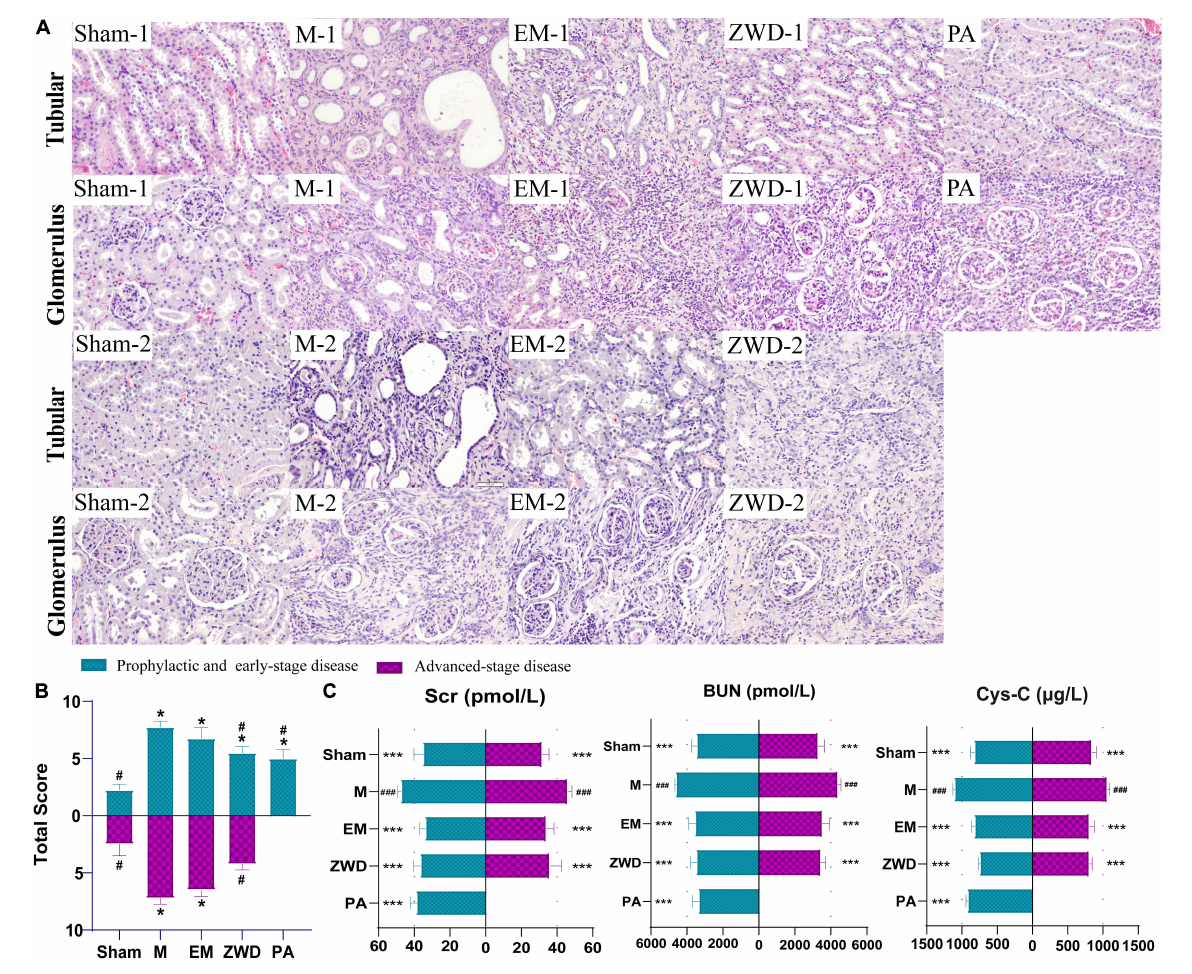
FIGURE2 (A) Representative HE staining images of the rat left kidney in each group (magnification, × 200). (B) Pathological scoring of kidney tissue. (C) Comparison of renal parameters (Cys-C, Scr, and BUN) under different interventions. Compared with the sham operation group, * P < 0.05, *** P < 0.001; compared with the model group, # P < 0.05, ### P <